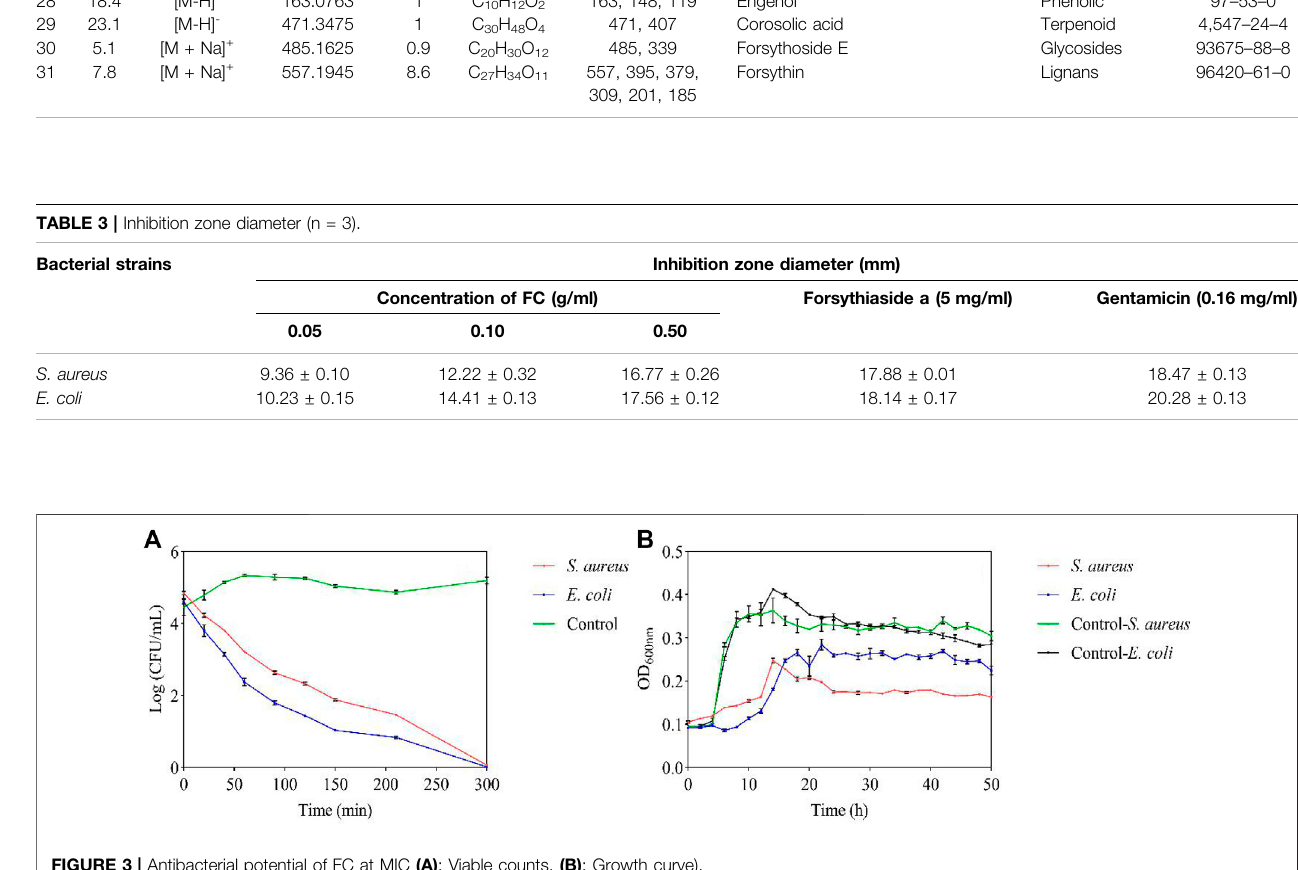
Frontiers in Pharmacology |